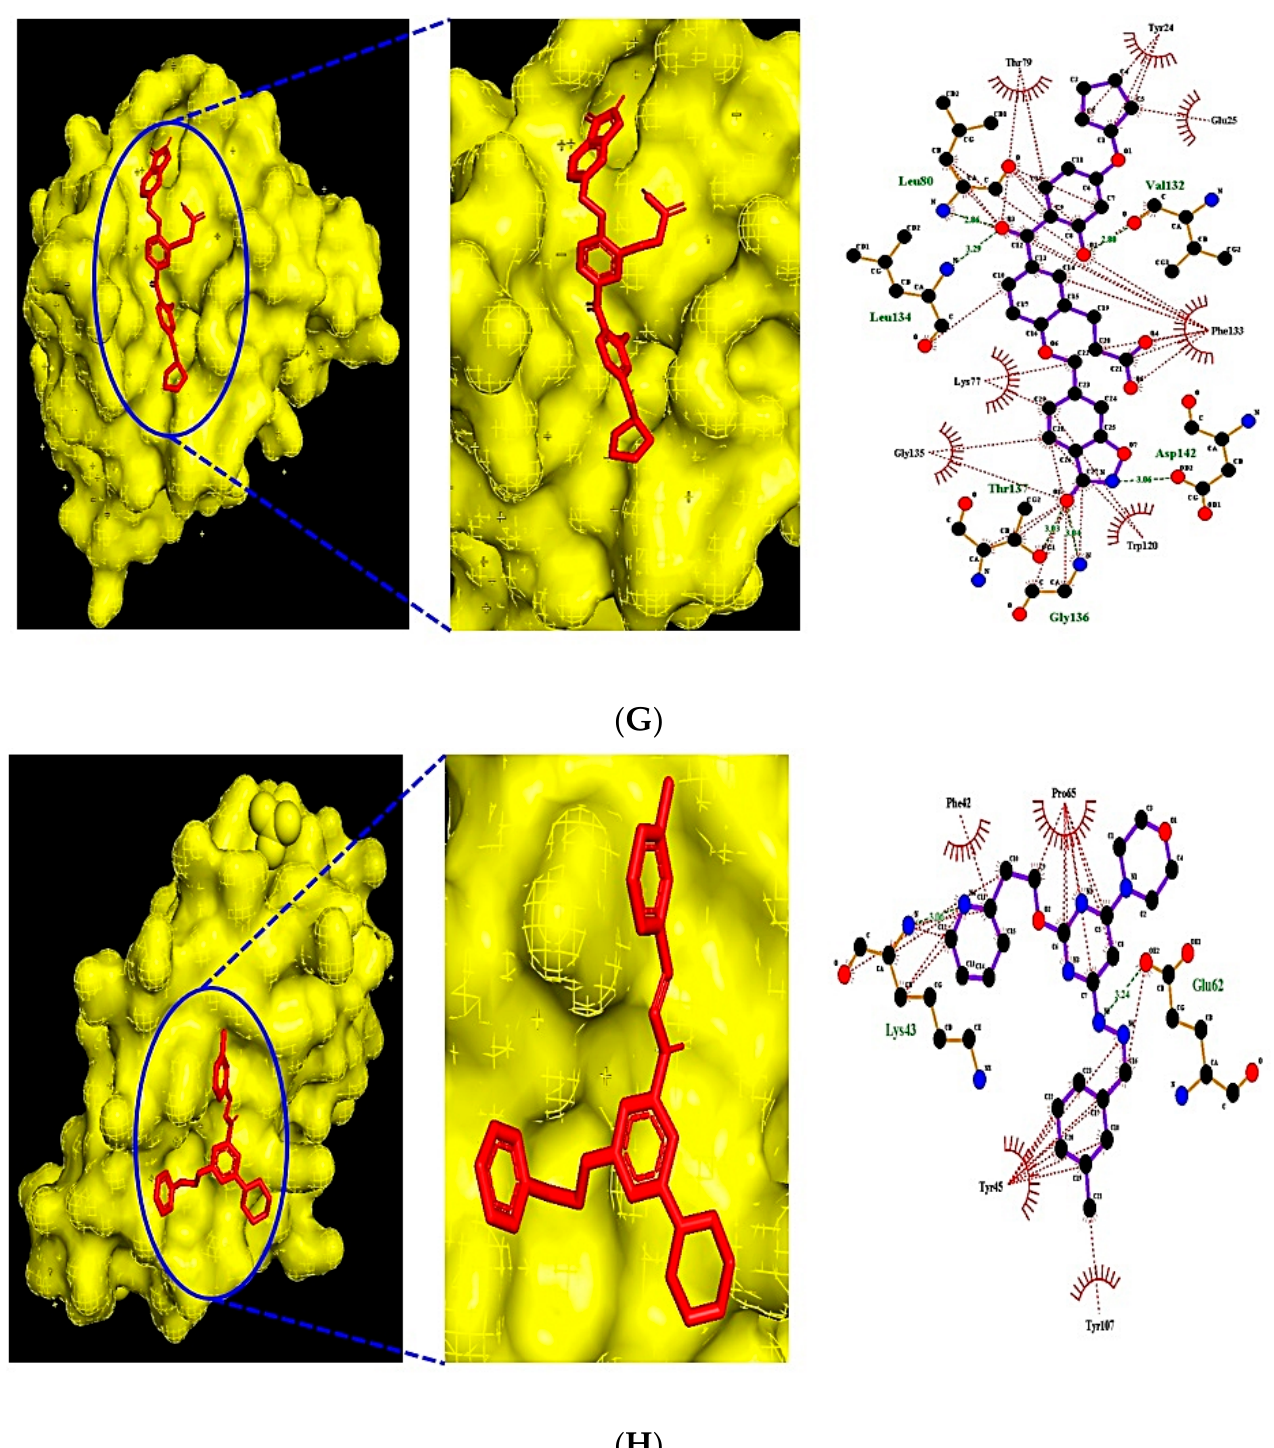
Figure 5. The molecular docking figure of the core eight ligands on key eight targets ( A ) CCL2 (PDB